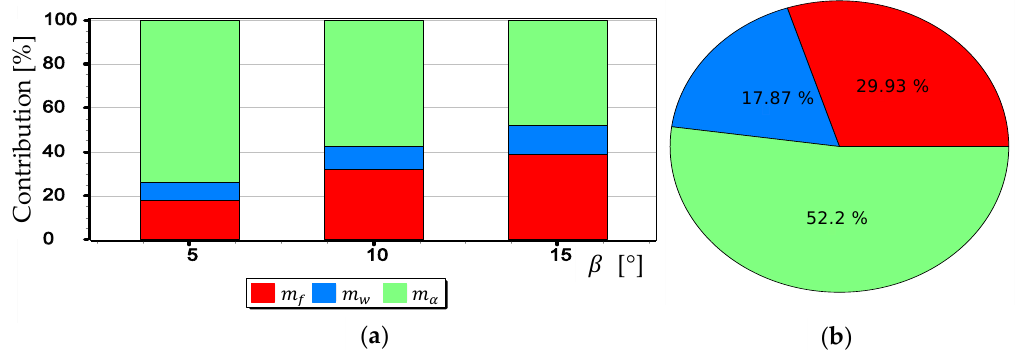
Figure 27. Percentage contribution for SONY ILCE-7RM2 camera: ( a ) Calculated for 𝛽 equals 5°, 10° and 15° ; ( b ) Calculated as a mean value.